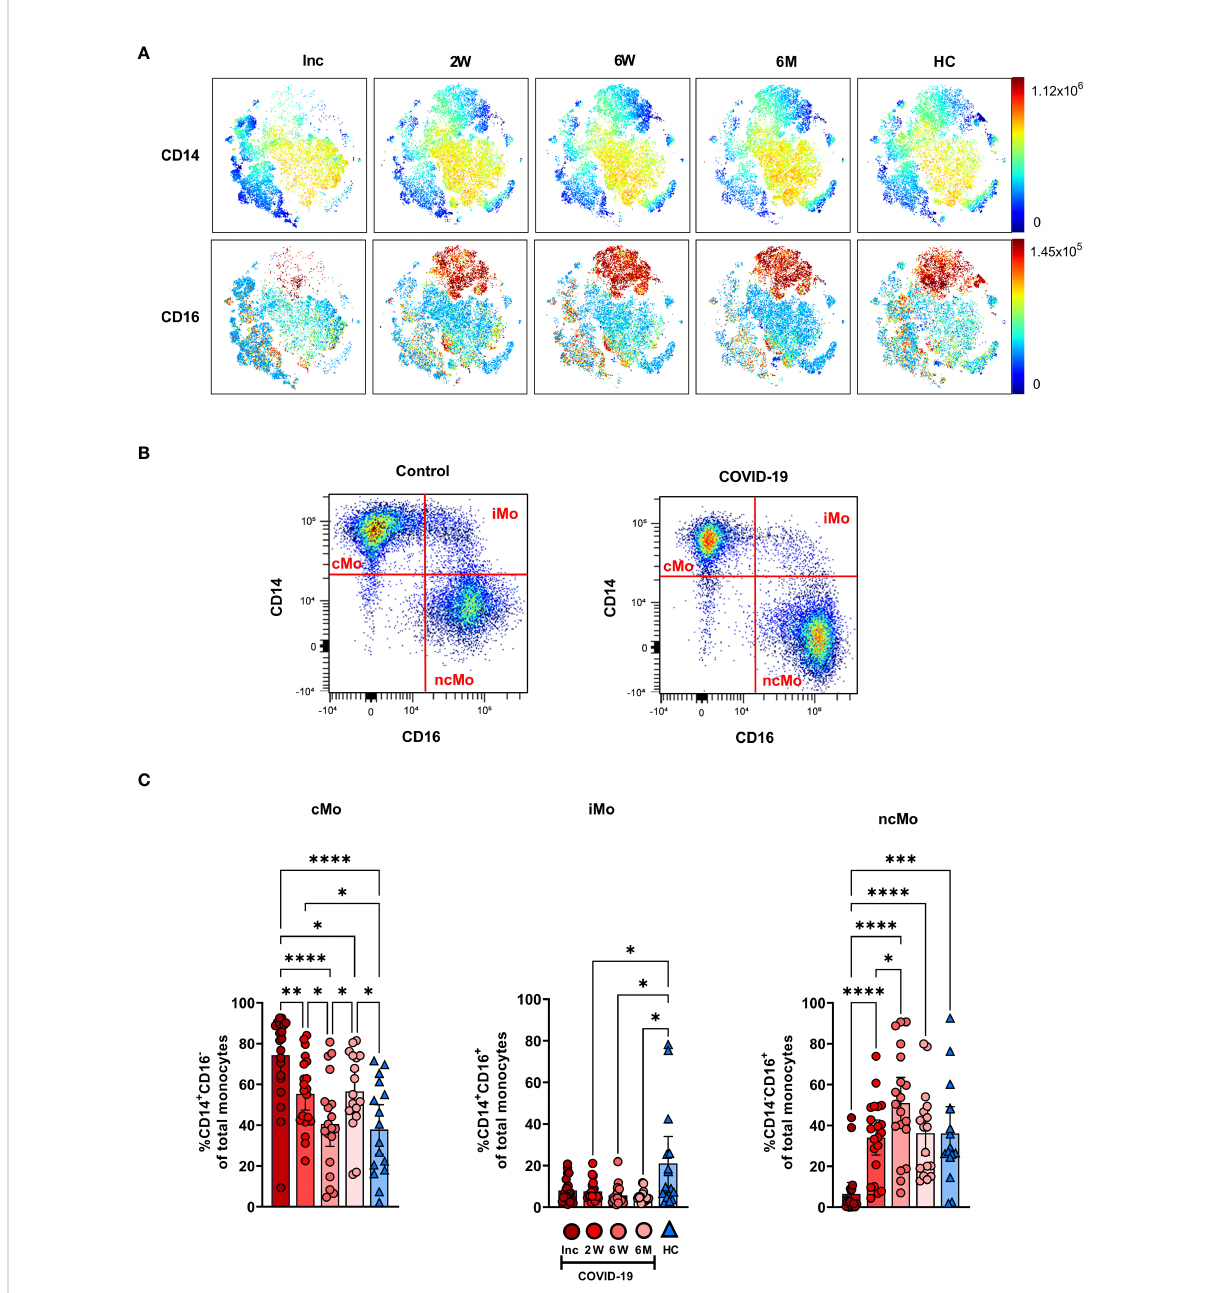
FIGURE 3 Classical and intermediate monocyte cells subsets remain altered in COVID-19 patients at 6 months. PBMCs were collected from COVID-19 patients that required hospitalization (N=21) and healthy controls (N=16) over a 6 − 7-month period. Cells were stained with antibodies for fl ow cytometry to de fi ne the monocyte subsets. (A) tSNE plots displaying myeloid cell clusters, colored according to their intensity of CD14 and CD16 expression. (B) Representative plots illustrating how monocyte subsets were de fi ned. (C) Frequencies of the CD14 + CD16 - cMo, CD14 + CD16 + iMo, and CD14 - CD16 - ncMo. Data is represented as mean with 95% Cl, with signi fi cance of *p ≤ 0.05, **p ≤ 0.01, ***p ≤ 0.001, ****p ≤ 0.0001, determined using Brown-Forsythe and Welch ANOVA tests. Inc, Study inclusion; 2W, 2 weeks; 6W, 6 weeks; 6M, 6-7 months; HC, healthy